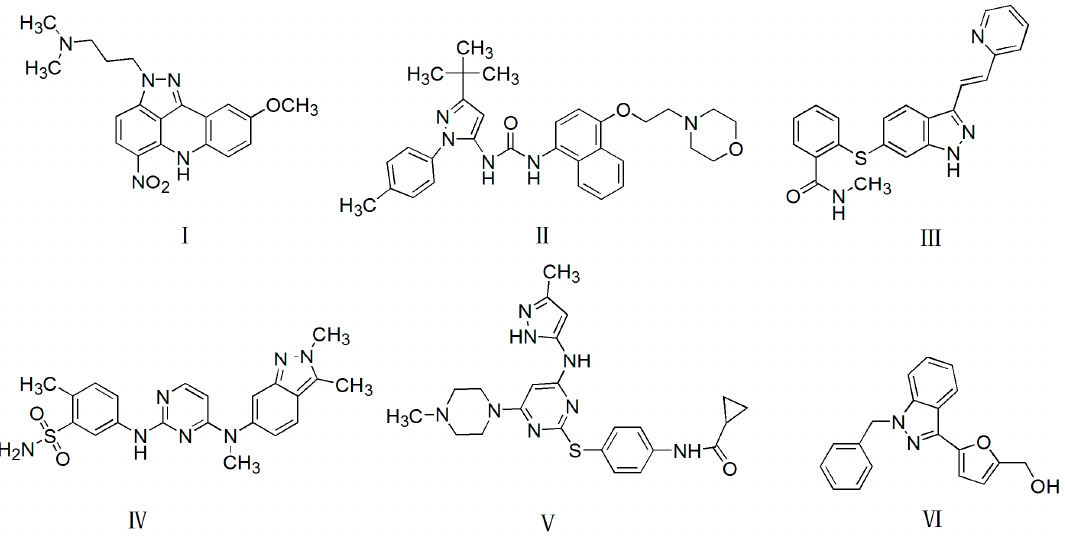
Figure 1. Structures of pyrazoloacridine (PZA) ( I ); doramapimod (BIRB-796) ( II ); axitinib (AG013736) ( III ); pazopanib (GW786034) ( IV ); tozasertib (VX-680) ( V ); and 3-(5’-hydroxymethyl-2’-furyl)-1-benzyl